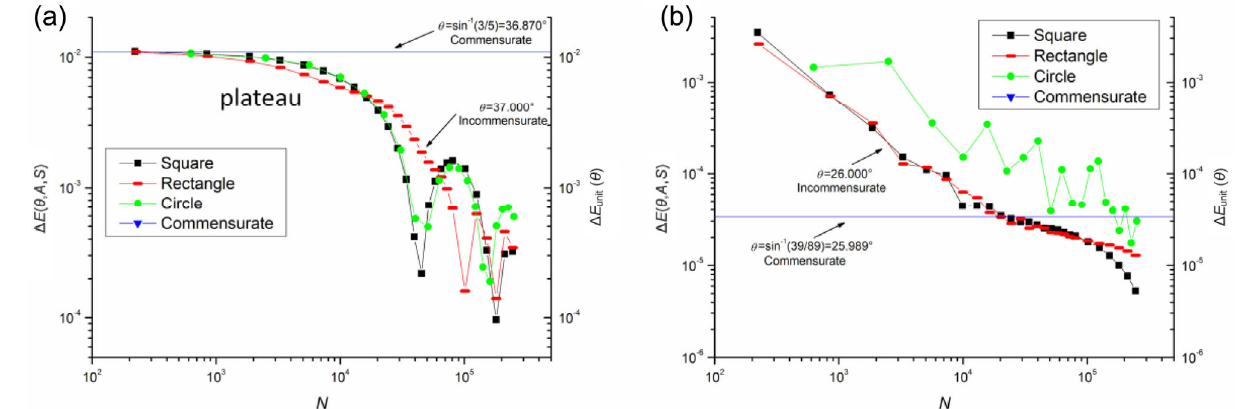
Fig. 7 Comparisons between commensurate contact and incommensurate contact with small difference in θ . Δ E unit ( θ ) versus N is shown for commensurate contact and Δ E ( θ , A , S ) versus N is shown for incommensurate contact. (a) is the comparison between θ = sin − 1 (3 ⁄ 5) = 36.870° (commensurate) and θ = 37° (incommensurate). (b) is the comparison between θ = sin − 1 (39 ⁄ 89) = 25.989° (commensurate) and θ = 26° (incommensurate). When N is small, only in the case of A , there is a plateau of Δ E ( θ , A , S ) in incommensurate contacts and the plateau is closed to Δ E unit ( θ ) of the commensurate contact. When N is large enough, in both cases there is a significant difference in Δ E ( θ , A , S ) between commensurate and incommensurate